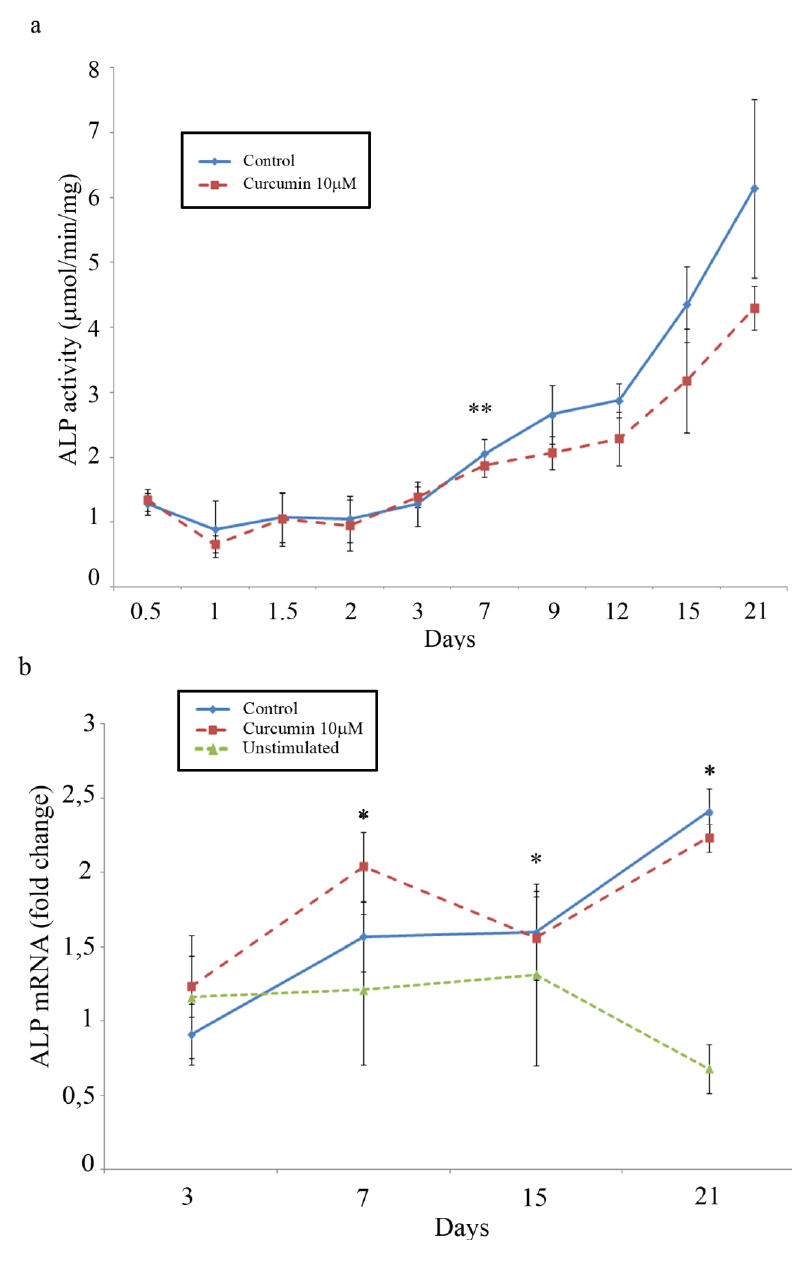
Figure 5. ( a ) The ALP activity of MG-63 cells at 0.5, 1, 1.5, 2, 3, 7, 9, 12, 15 and 21 post seeding in the presence of either osteogenic medium or osteogenic medium + curcumin 10 µM. ** ( p < 0.001 vs. day 0.5 in both conditions). Significant differences ( p < 0.001) were found from day 9 of culture to the end of the experiment between the experimental conditions. ( b ) Time course of alterations in ALP mRNA concentration after the 3, 7, 15 and 21 day of exposure to 10 µM curcumin + osteogenic medium, osteogenic medium or culture medium (unstimulated). Total cellular RNA was extracted from MG-63 cells as described in Methods. ALP mRNA amount was determined by performing RT-PCR. Data represent the mean ± SEM for a minimum of three separate experiments. * Significant difference compared to unstimulated cells ( p < 0.05). Not significant differences were found between curcumin stimulated cells and osteogenic